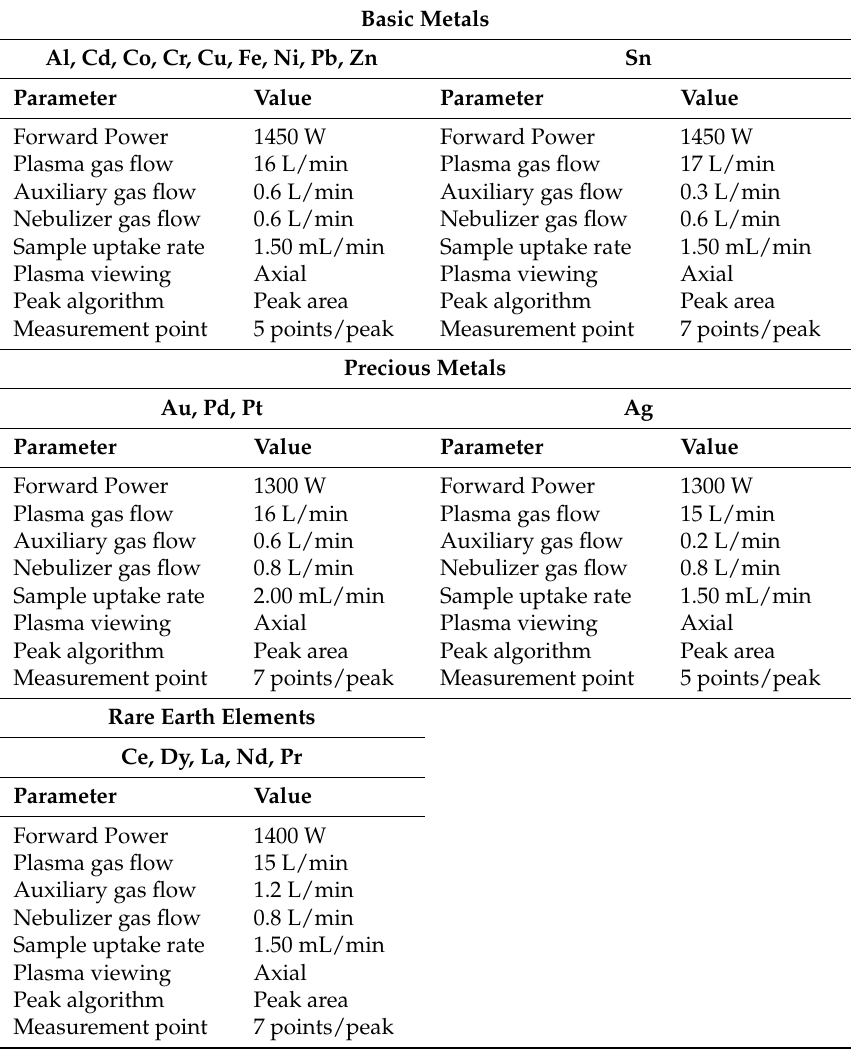
Table 5. ICP-OES operating